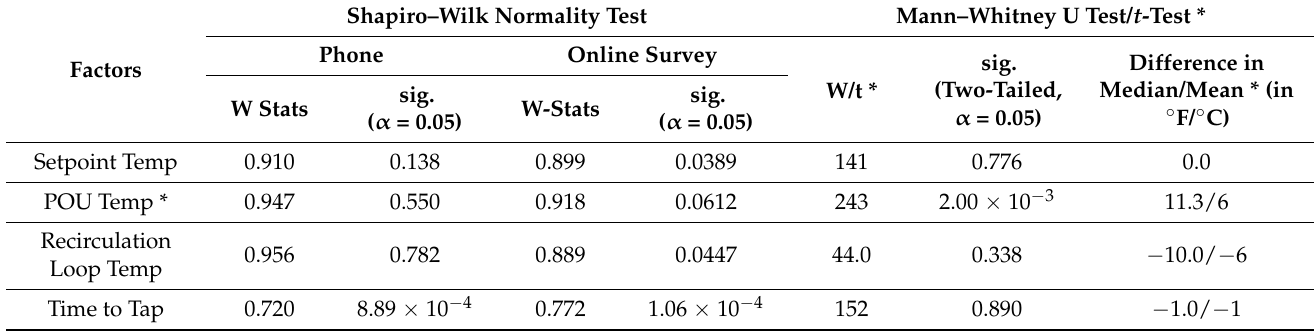
Table 2. Results of Shapiro–Wilk test for normality and independent-samples t -test and Mann– Whitney U test of difference between phone and online survey